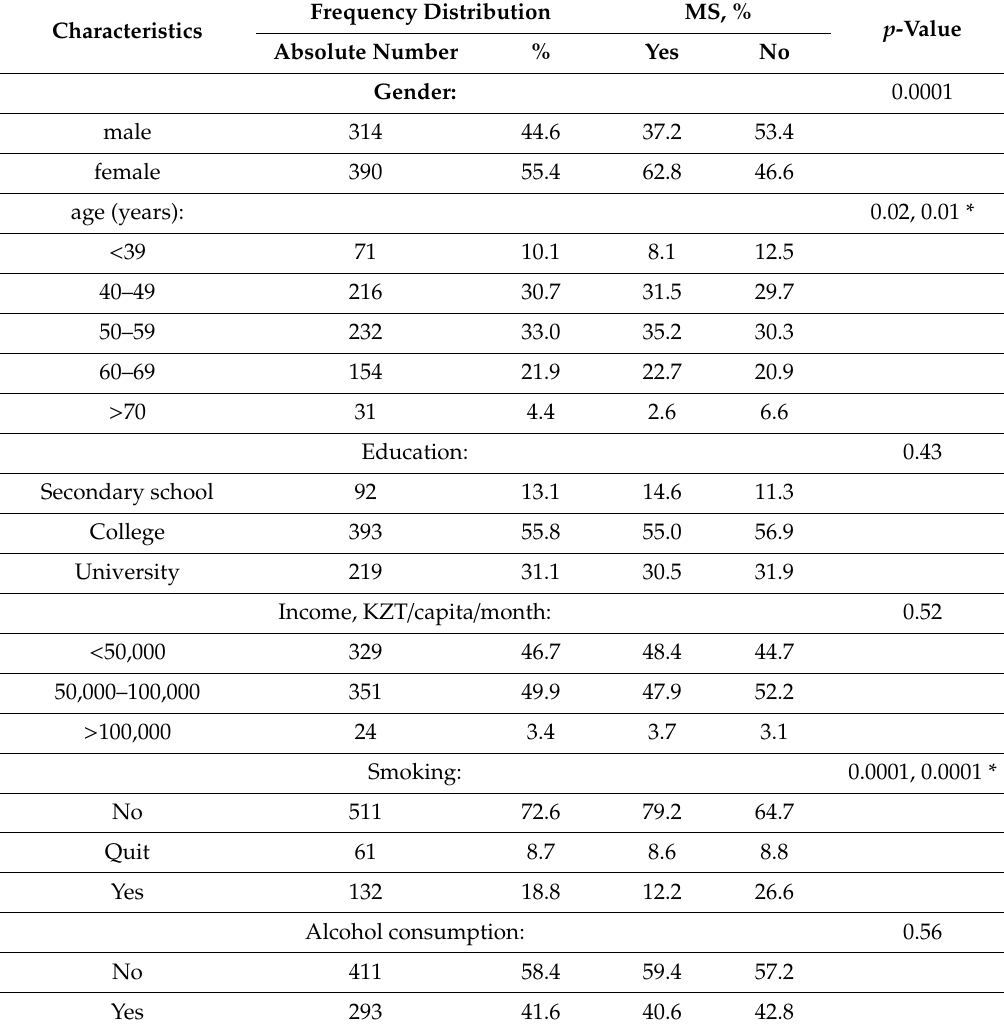
Table 1. Basic demographic and clinical characteristics of the study population (N = 704). Frequency Characteristics